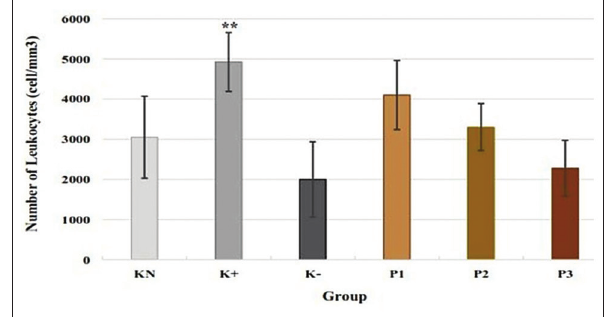
Figure-3: Effect of polysaccharides from Caribena versicolor on phagocytic activity (%). KN=Normal control, K+=Positive control, K−=Negative control, P1=Administration of polysaccharides (PS) before infection, P2=Administration of PS after infection, P3=Administration of PS before and after infection. Values are represented as means±standard deviation (n=6). **p<0.05 compared to KN group.